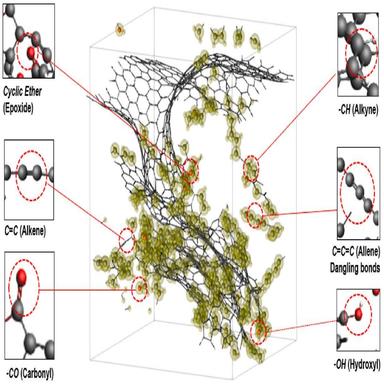
Functional groups developed on GrGC nanostructure during pyrolysis of SU-8 polymer precursor and Gr monolayer. Consistent with FTIR characterizations, the model qualitatively predicted carbonyl (C– –O), ether (C–O–C), hydroxyl (-OH), epoxide (cyclic ether), and alkyne (-CH) functional groups. (A colour version of this figure can be viewed online.)